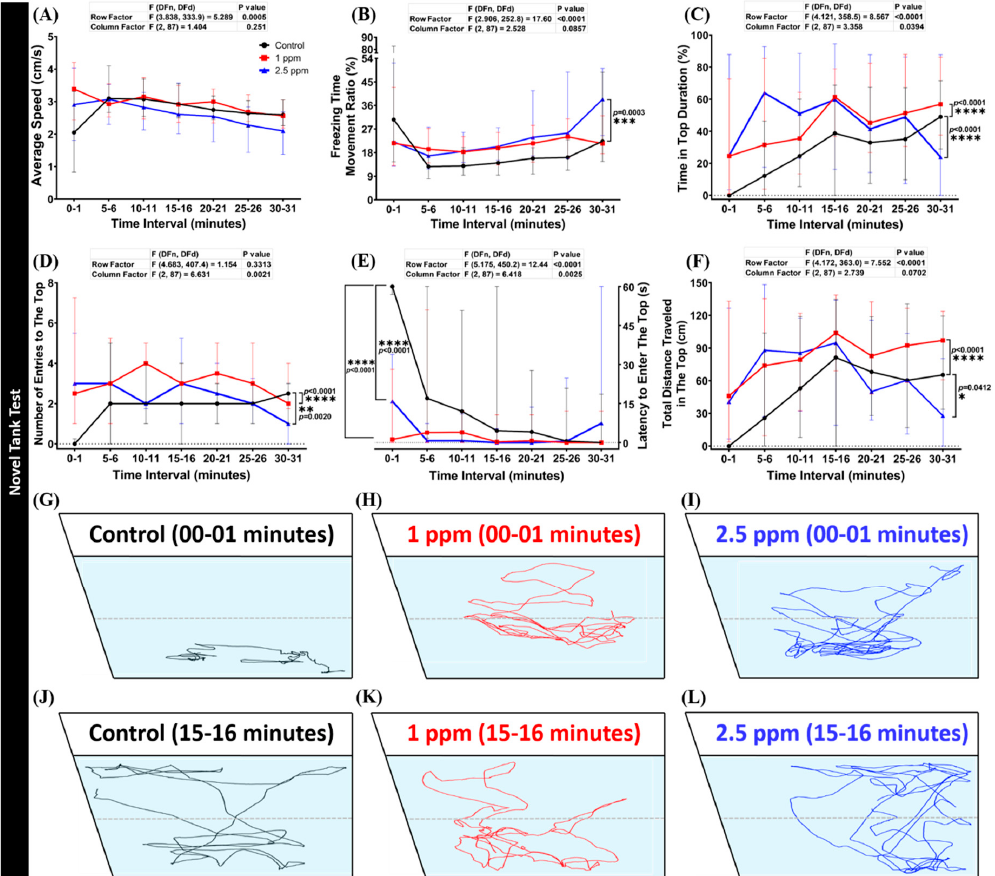
Figure 2. Behavior endpoints of control and donepezil-exposed zebrafish in novel tank test after 14 days of incubation: ( A ) average speed; ( B ) freezing time movement ratio; ( C ) time in top duration; ( D ) number of entries to the top; ( E ) latency to enter the top; and ( F ) total distance traveled in the top were analyzed. The swimming trajectories of ( G , J ) control; ( H , K ) 1 ppm Donepezil-exposed fish; and ( I , L ) 2.5 ppm Donepezil-exposed fish for novel tank test after 1 min and 15 min were recorded and compared. The black line represents control and the red line represented 1 ppm Donepezil-exposed fish, while the blue line represents 2.5 ppm Donepezil-exposed fish. The data are expressed as the median with interquartile range and were analyzed using a two-way repeated measure ANOVA with Geisser–Greenhouse correction. To observe the main column (donepezil) effect, Dunnett’s multiple comparison test was carried out; n = 30, * p < 0.05, ** p < 0.01, *** p < 0.005, **** p < 0.001.